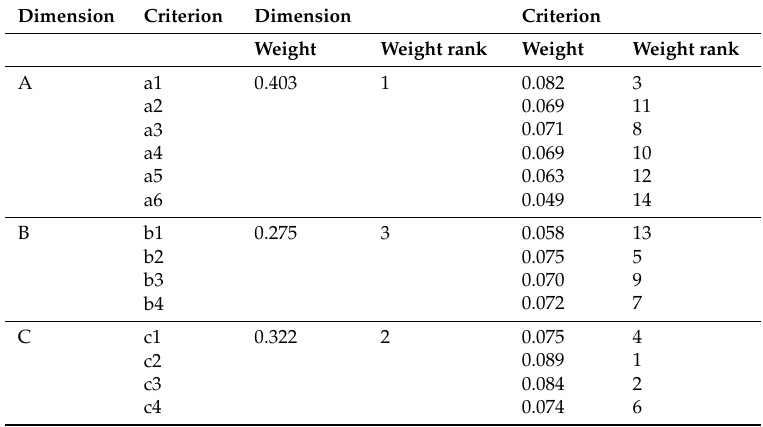
Table 16. Weights of each dimension, criterion, and weight rank.